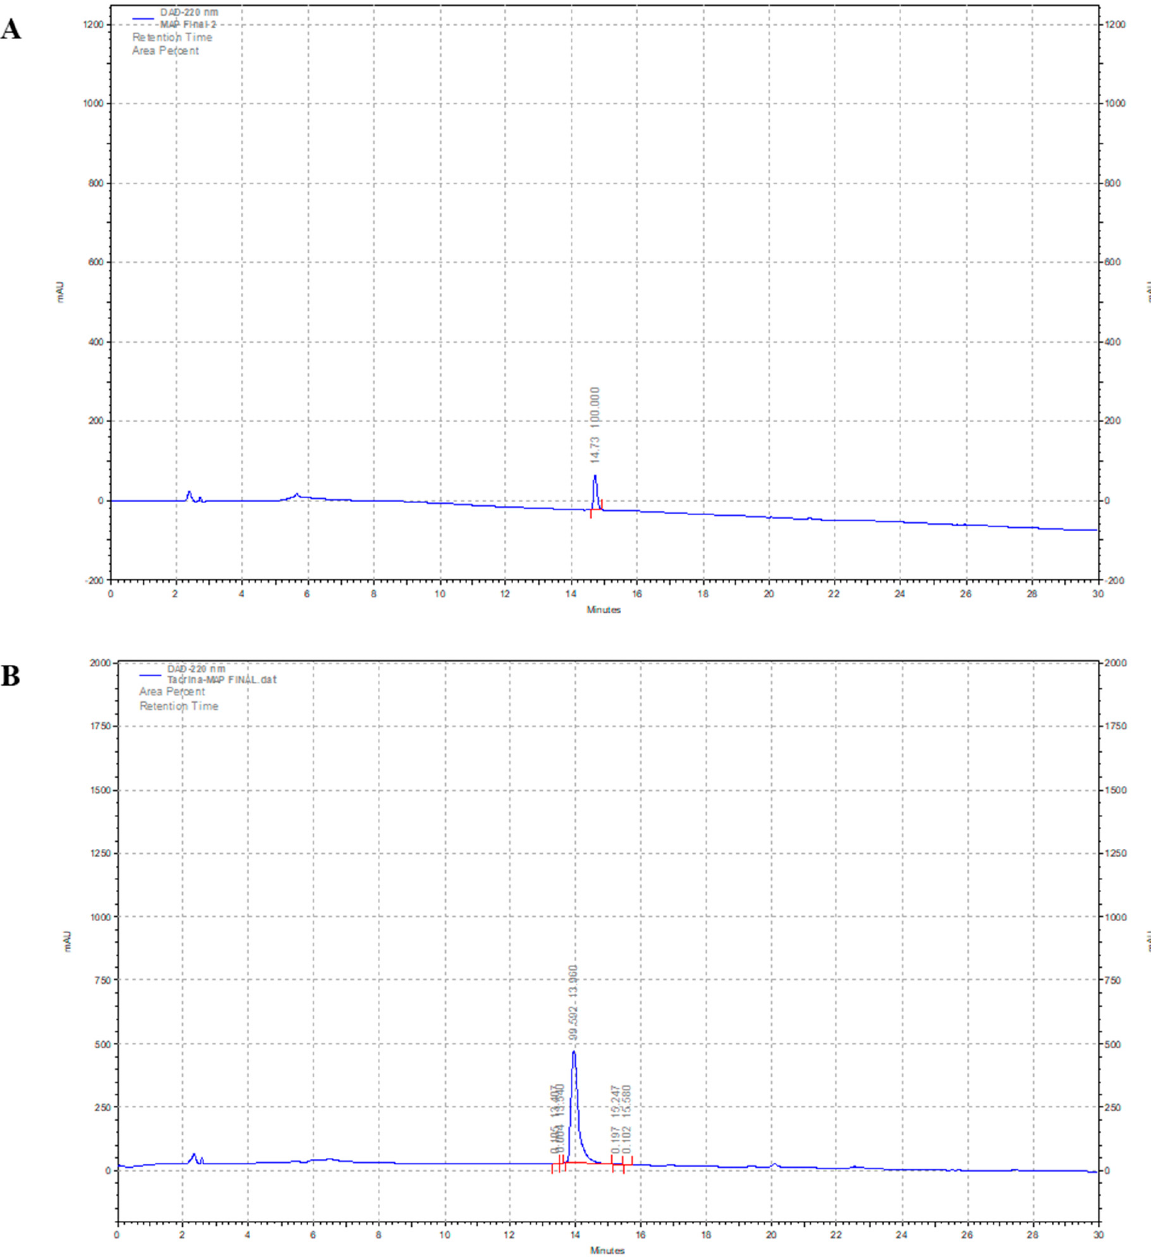
Figure 2. Chromatograms of synthetic MAP ( A ) and MAP-Tacrine conjugate ( B ), acquired with an HPLC system, with a C18 column, using ACN and acidified water (0.05% TFA) as eluent, in gradient mode (0–100%), for 30 min, at a flow rate of 1 mL/min and detection at λ = 220 nm.